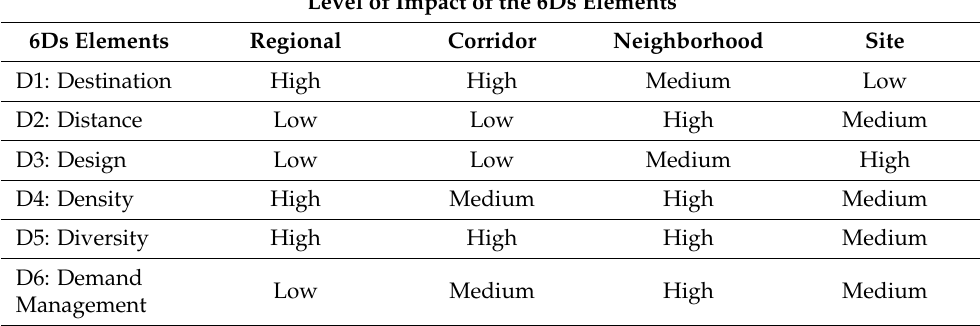
Table 2. Level of impact of the 6Ds Elements within metro station catchment area according to the geographical location (source: Data modified from [38]).